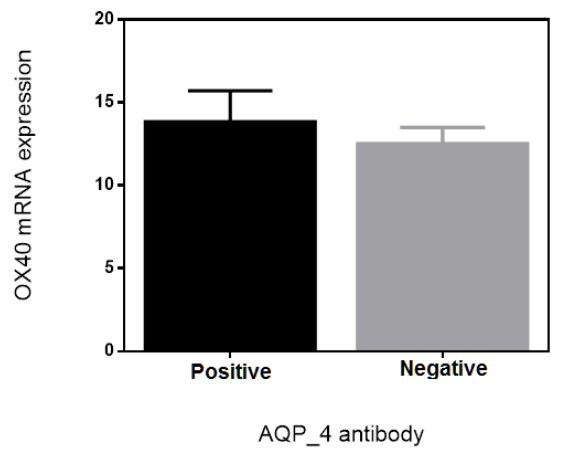
Figure 2: sOX40 serum levels in AQP4 seropositive and -negative NMO patients. There were no significant differences between the two groups (p = 0.044.). Values shown are means ± SD from 6 seropositive and 12 seronegative NHO